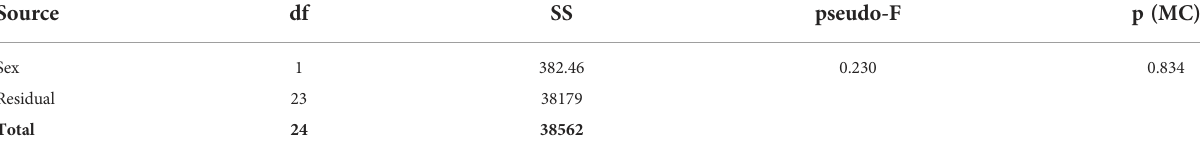
TABLE 1 General PERMANOVA results of biometric parameters distribution between male and female polyps.